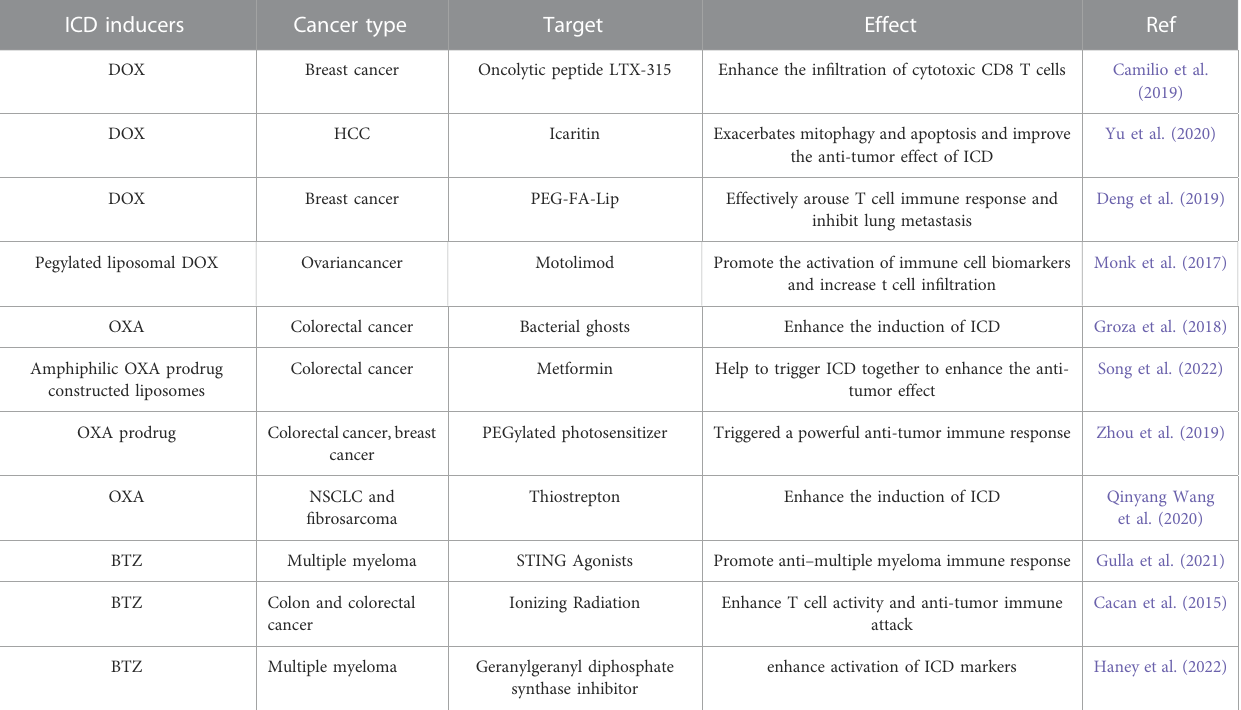
TABLE 1 The chemoreagents involved in the ICD